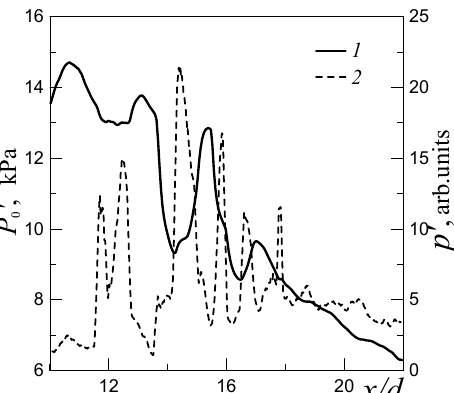
Figure 13. Pitot pressure P 0 ' (solid curve 1 ) and amplitude of acoustic oscillations p' of mode B (dotted curve 2 ) versus the normalized distance from the nozzle; d = 0.72 mm, D = 0.4 mm, and n = 3.